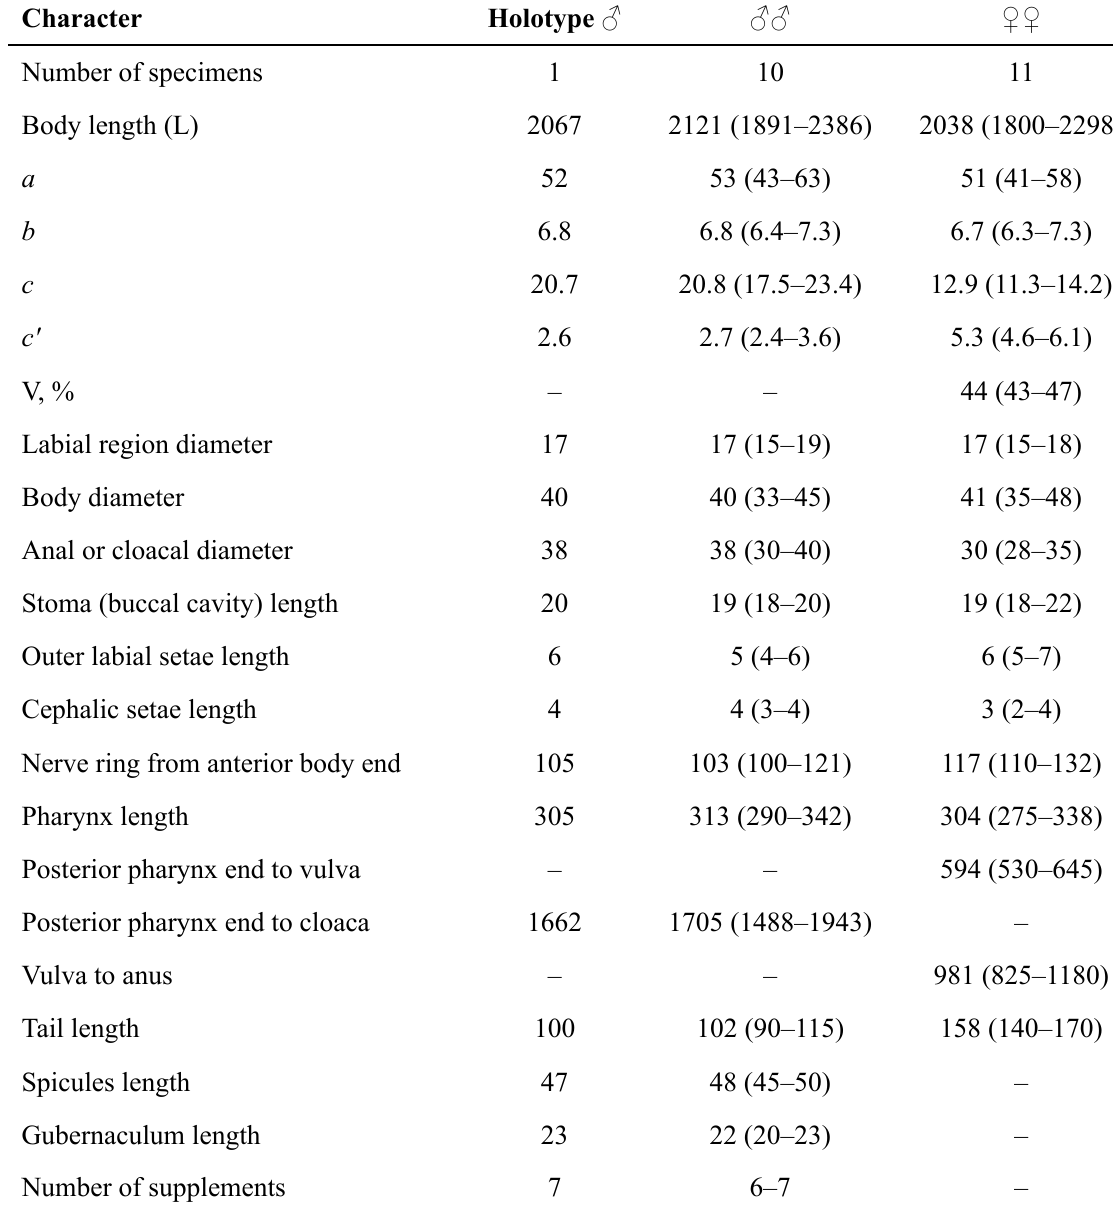
Table 2. Measurements (in µm) of Tobrilus juliae sp. nov., presented as mean and